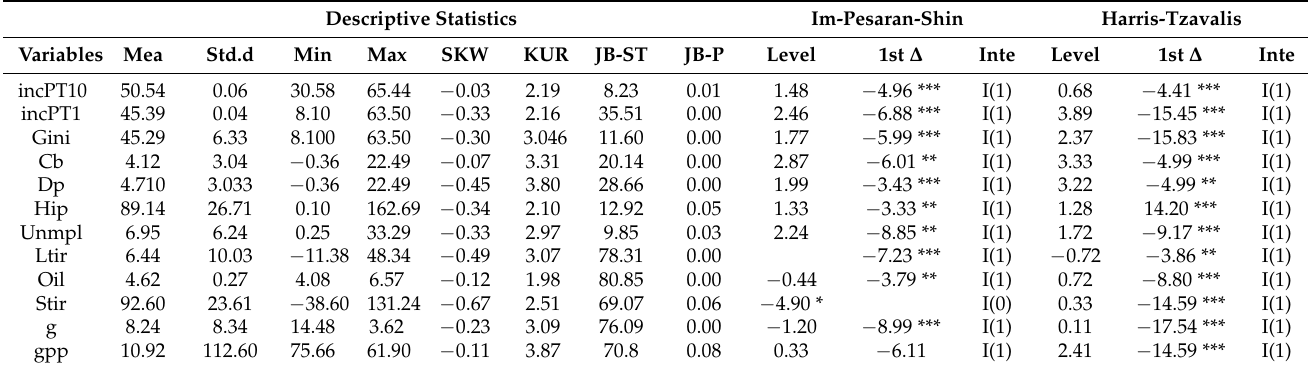
Table 1. Descriptive Statistics and the Panel Stationarity